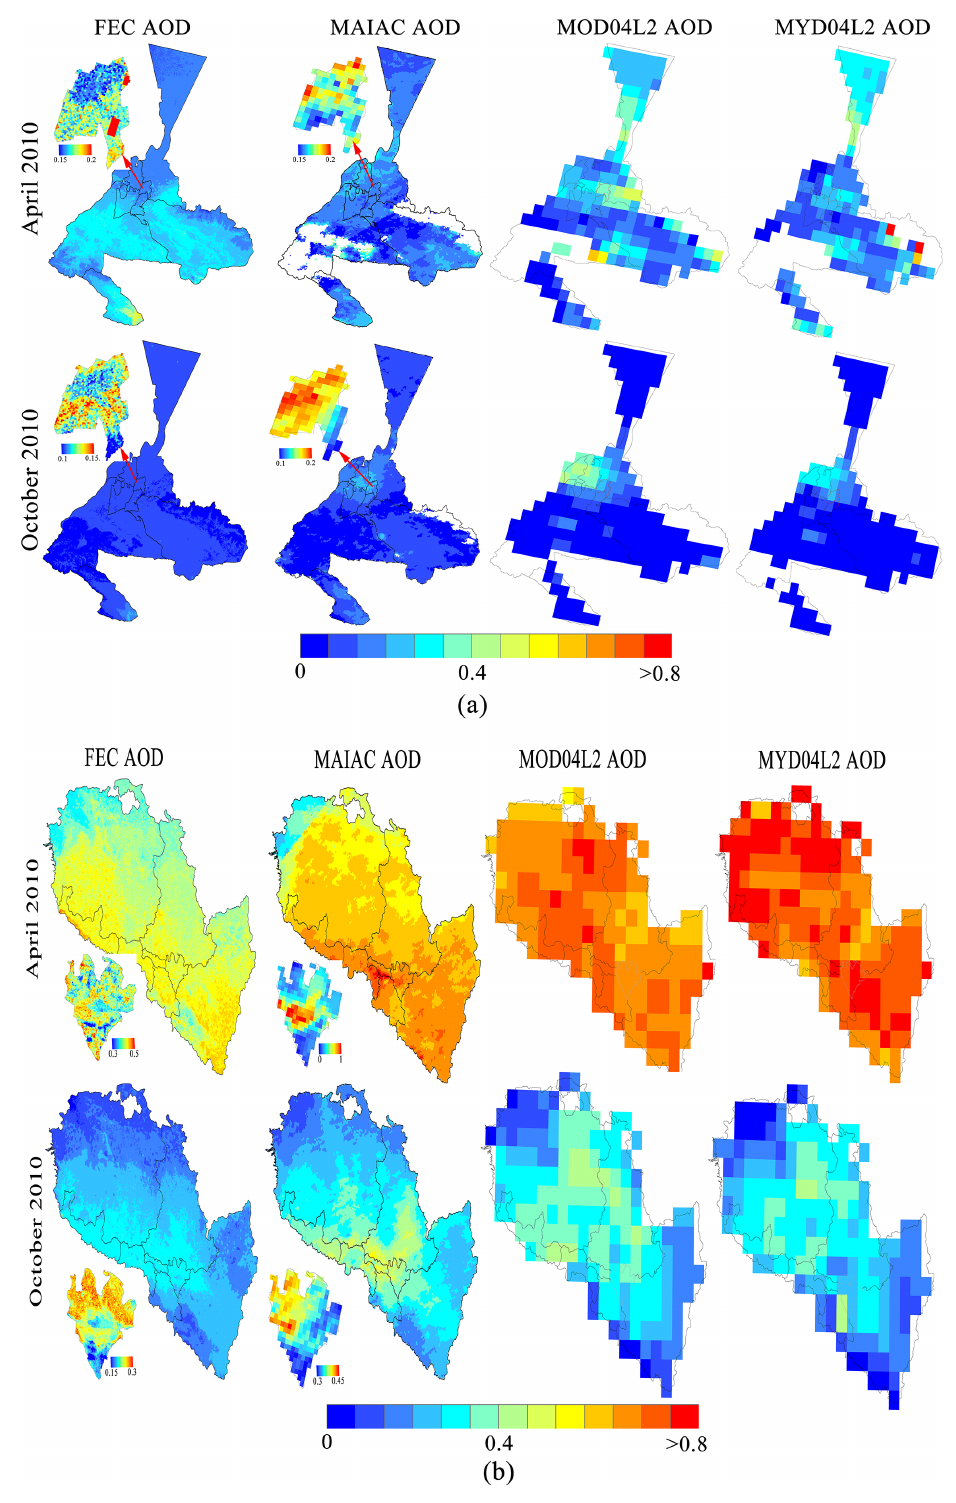
Figure 14. The spatial patterns of four AOD products in April and October 2010: (a) Urumqi and (b) Lanzhou.